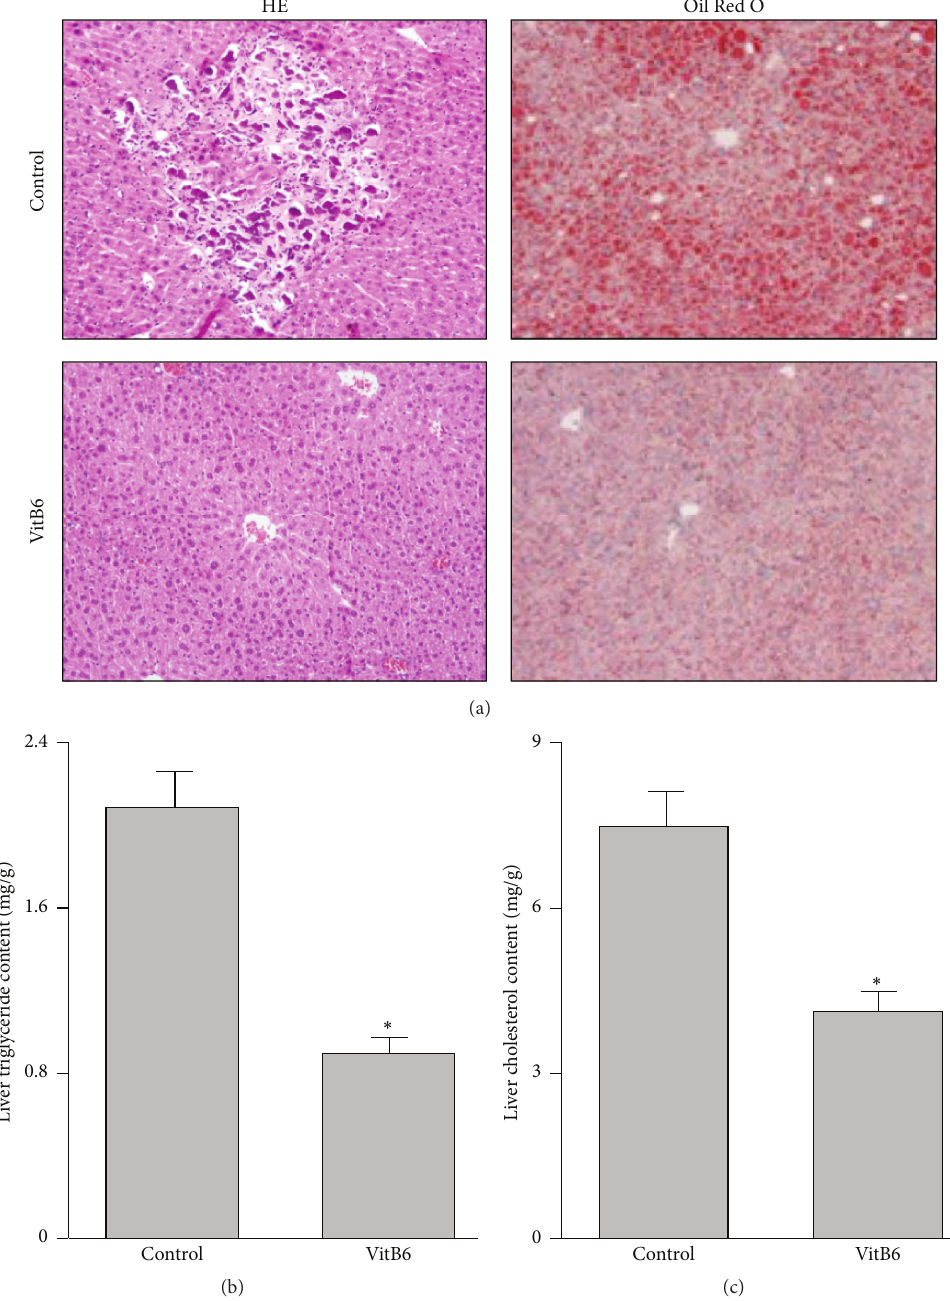
Figure 3: VitB6 reduces hepatic lipid accumulation in 𝐴𝑝𝑜𝑒 −/− mice fed with high-fat diet. Male 𝐴𝑝𝑜𝑒 −/− mice at the age of 6 weeks received high-fat diet and VitB6 (50mg/kg/day) administration in drinking water. At the end of experiments, mice were sacrificed under anaesthesia. (a)HistologicalanalysisoflivertissuebyHEorOilRedOstaining.(bandc)Liverlipidswereextractedandhepatictriglycerideandcholesterol levels were assayed using a commercial kit. The quantitative data were expressed as mean ± SEM. 𝑁 is 10–15 in each group. ∗ 𝑃 < 0.05 versus